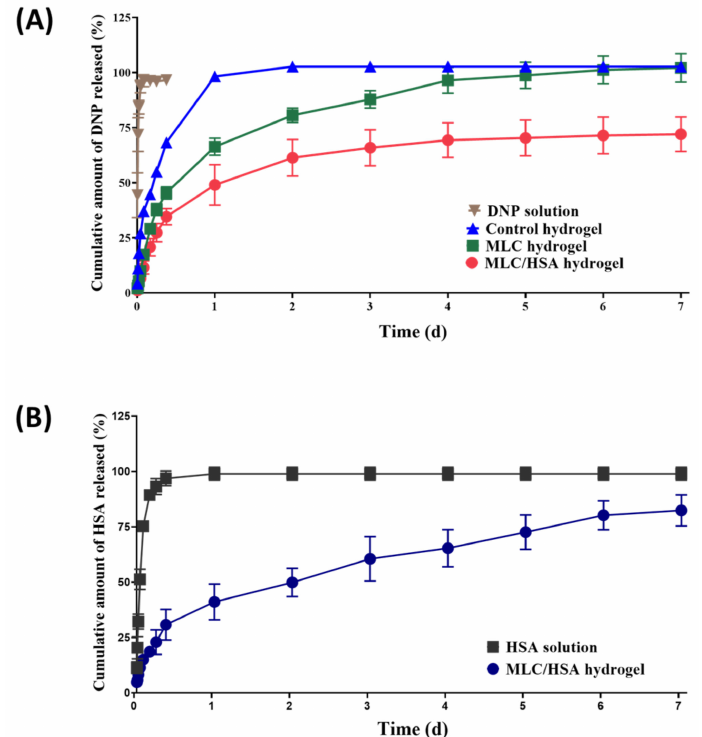
Figure 5. In vitro release profiles of DNP and HSA from hydrogels into PBS at 37 ◦ C. Cumulative amount of ( A ) DNP released from the developed hydrogels and of ( B ) HSA released from the MLC/HSA hydrogel. Each point represents the mean ± SD ( n =